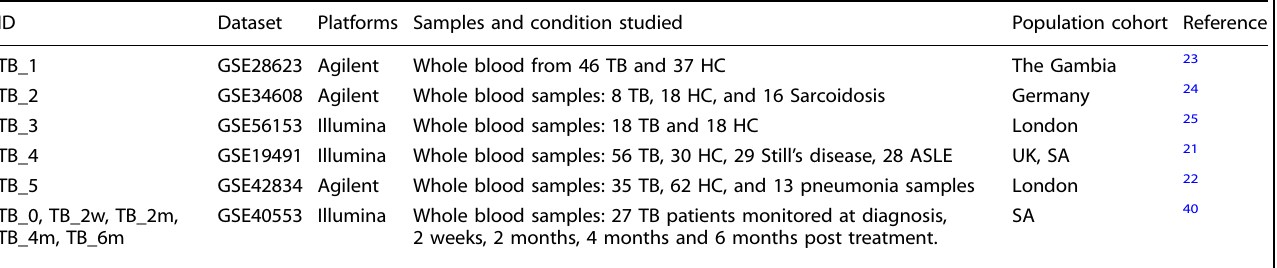
Table 1. Transcriptome datasets used in this study. The number of samples selected re fl ect the samples chosen post normalisation and clustering in each